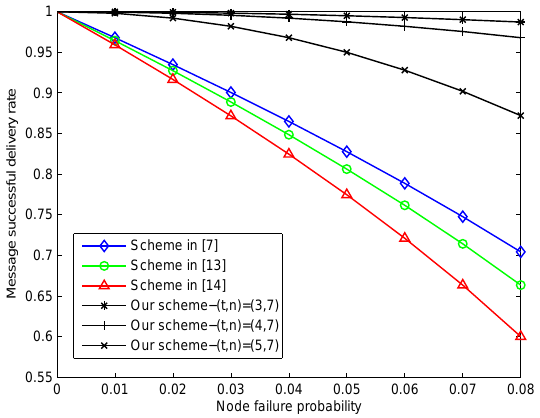
Figure 6. The successful message delivery rate with the node failure